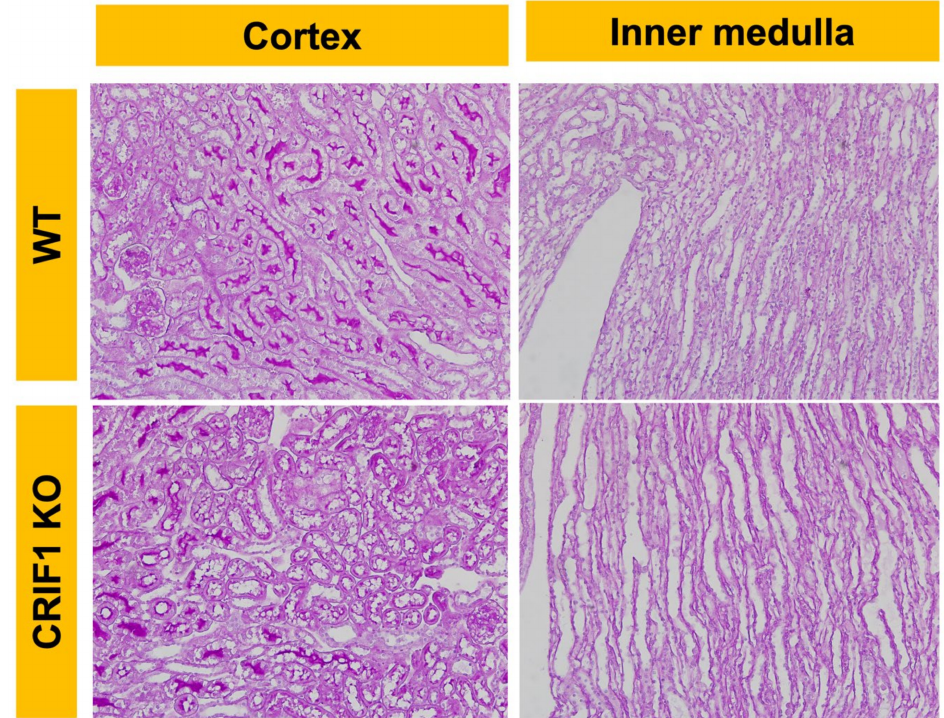
Figure 1. Photos of periodic acid–Schiff stain of wild-type (WT) and CR6-interacting factor-1 knockout (CRIF1-KO) mouse kidneys. No specific morphological differences are observed between WT and CRIF1-KO